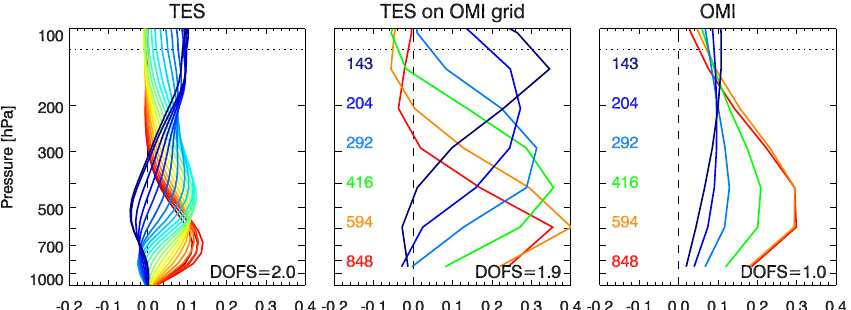
Fig. 1. Sample averaging kernel matrices for TES (left) and OMI (right) ozone retrievals below 100hPa (cloud-free ocean scene at 28 ◦ N, 58 ◦ W on 6 August 2006). Each line is a row of the averaging kernel matrix; row elements are dimensionless. The central panel shows TES averaging kernels recomputed as sensitivities to partial ozone columns on the OMI pressure level grid as described in Appendix A. The colored numbers are centers of the OMI pressure grid (hPa). Red colors represent relatively high pressure levels and blue colors represent relatively low pressure levels. The degrees of freedom for signal (DOFS) in the troposphere are shown inset. The horizontal dotted line shows the tropopause pressure (120hPa) used for this retrieval.